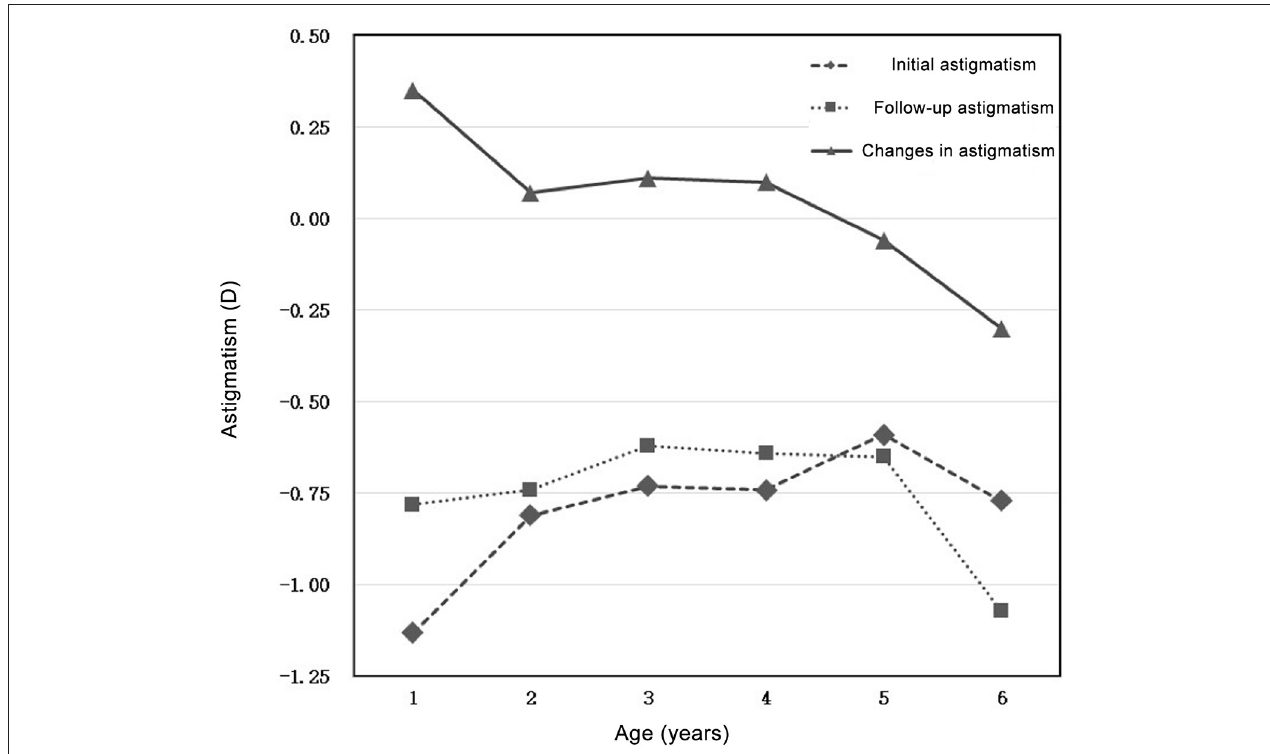
FIGURE 2 | Initial astigmatism, follow-up astigmatism, and changes in astigmatism in preschool children aged 1–6 years.